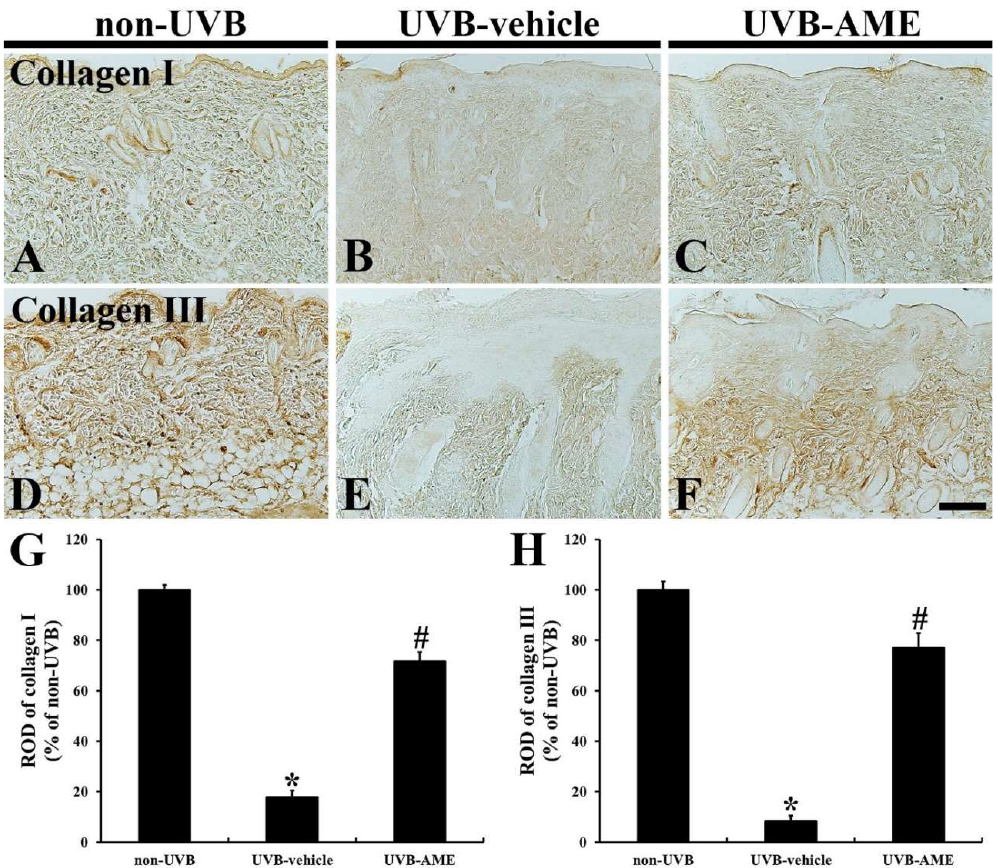
Figure 5. ( A – F ) Immunohistochemistry for collagen I ( A – C ) and III ( D – F ) in the dorsal skin of the non-UVB ( A and D ), UVB-vehicle ( B and E ) and UVB-AME ( C and F ) at 7 days after UVB irradiation. In the UVB-vehicle group, collagen I and III immunoreactivity is apparently diminished compared to that in the non-UVB group. In the UVB-AME group, however, collagen I and III immunoreactivity is significantly reserved. Scale bar = 100 µ m. ( G and H ) relative optical densities (RODs) of collagen I ( G ) and III ( H ) immunoreactivity in the dorsal skin of each group at 7 days after UVB irradiation. Bars indicate the means ± SEM ( n = 10 in each group, * p < 0.05 vs. non-UVE group, # p < 0.05 vs. UVB-vehicle group).